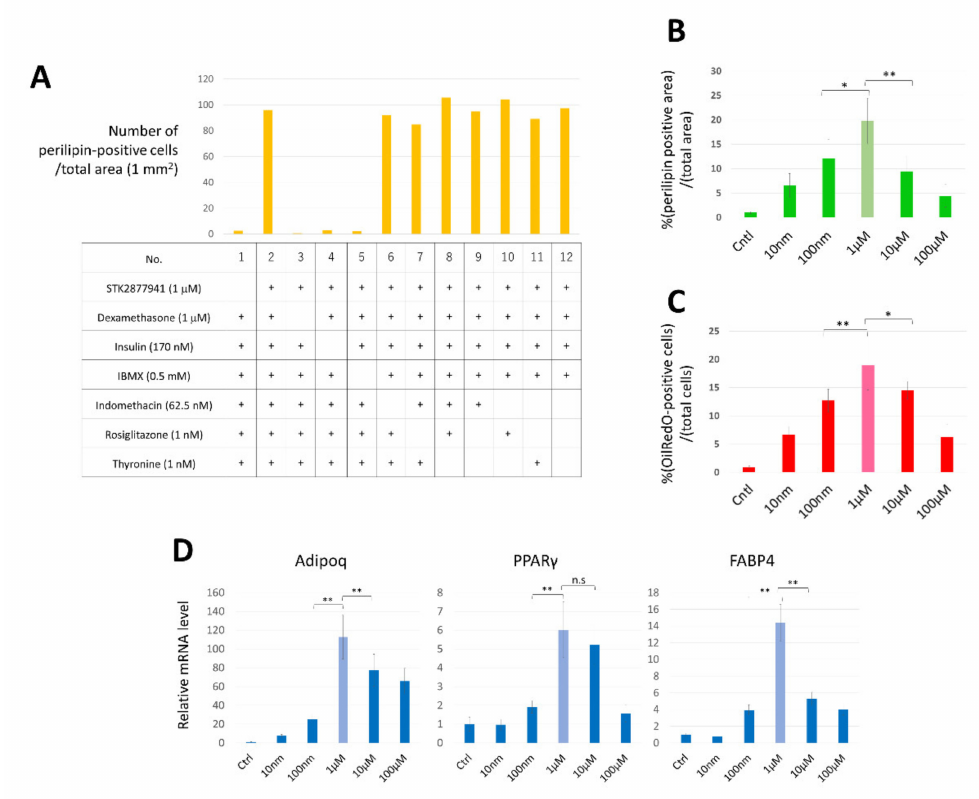
Figure 2. Optimization of culture conditions in which STK287794 converted HDFs to chemical compound-mediated directly converted adipocytes (CCCAs). ( A ) HDFs were cultured in complete medium supplemented with 1 mM sodium pyruvate and the indicated components for 14 days. Cells were immunostained with anti-perilipin antibody and the number of perilipin-positive cells/mm 2 was determined. ( B – D ) HDFs were cultured in induction medium supplemented with the indicated concentrations of STK287794 for 14 days. Cells were stained with anti-perilipin antibody ( B ) or OilRed O ( C ), and RNA was extracted from the cells and mRNA levels for the indicated adipocyte marker genes were measured by real-time RT-PCR ( D ). Data are expressed as the mean ± .SD from sextuplicate ( A ) or triplicate ( B – D ) samples. Relative values to control (set to 1.0) are plotted. * p < 0.05, and ** p < 0.01 vs. control group. ns: not